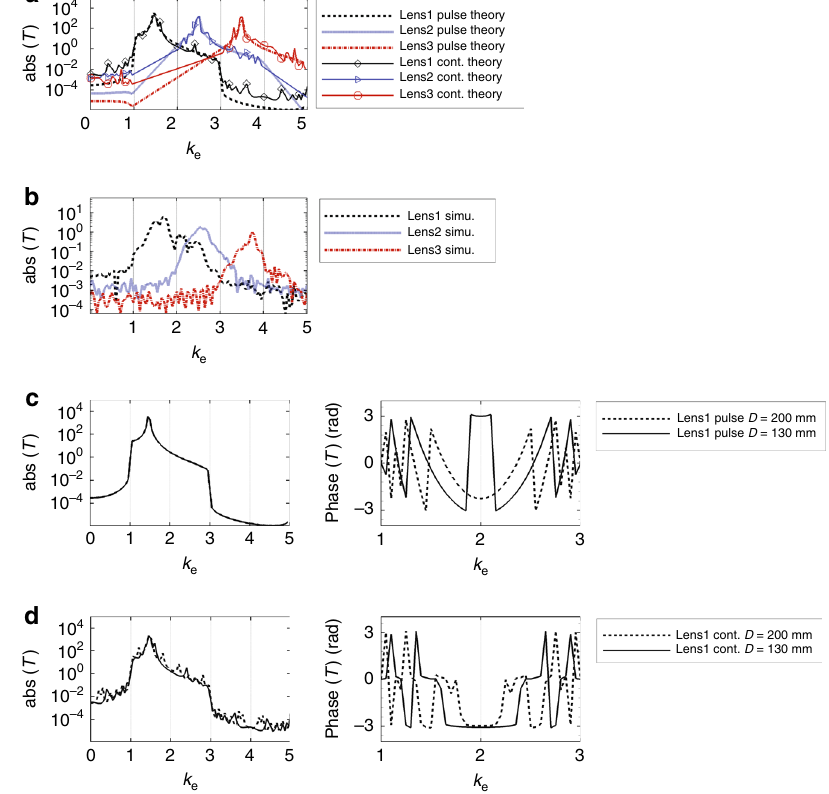
Fig. 4 Transmission properties of the whole system. a Amplitudes of theoretically calculated image transfer functions of lens1, lens2 and lens3 for pulse source case and continuous source case. Lens1, lens2 and lens3 correspond to systems that work for wave vectors in k e ∈ [1, 2], [2, 3], and [3, 4], respectively. b Amplitudes of simulated image transfer function of lens1, lens2 and lens3. Simulation is performed in frequency domain, taking into consideration the multiple re fl ections between gratings. c When using continuous source, theoretically calculated amplitudes and phases of image transfer functions for lens1 when D = 130 mm and D = 200 mm. D is the distance between the transmitter and the receiver. d When using pulse source, theoretically calculated amplitudes and phases of image transfer functions for lens1 when D = 130 mm and D = 200